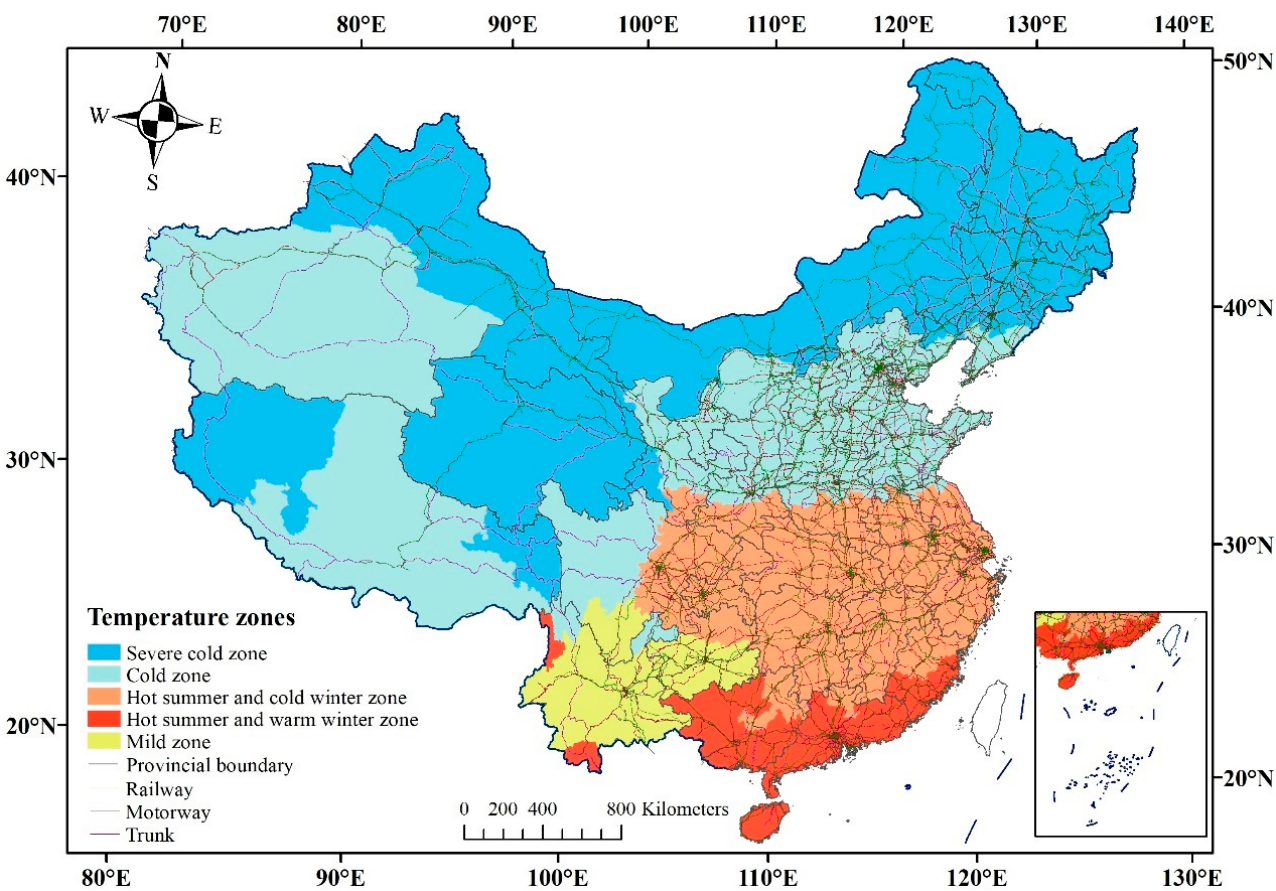
Figure 1. Temperature zones—building climate demarcation in China. Note: Transportation data were obtained from Open Street Map (https://www.openstreetmap.org/, accessed on 1 January 2021).